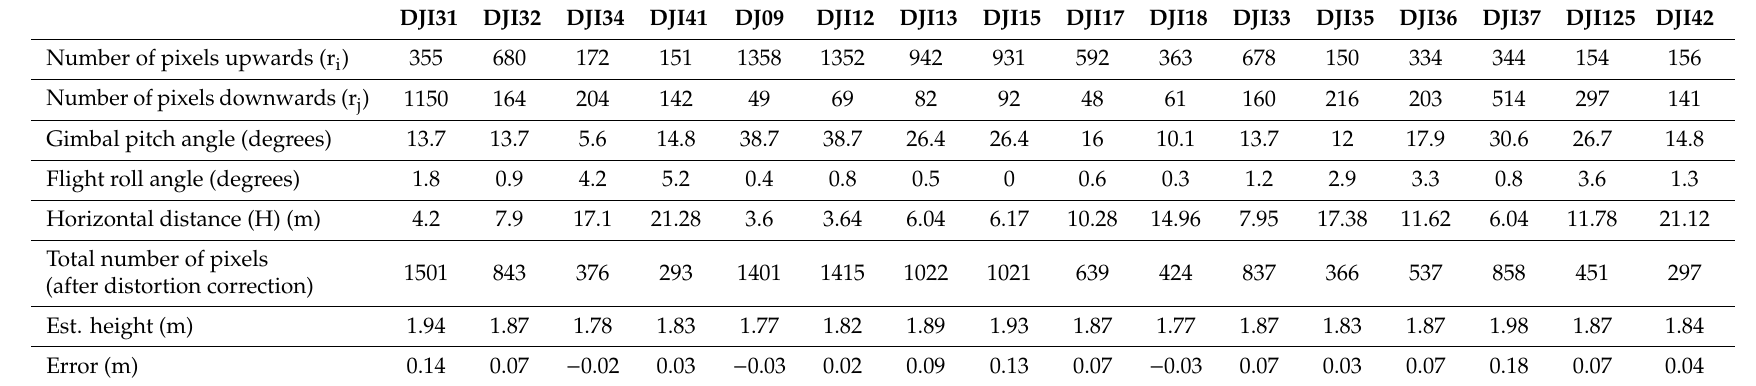
Table 3. Data and results for the first 16 still images acquired with the lightweight UAV with a Pole of 1.80 m as target.